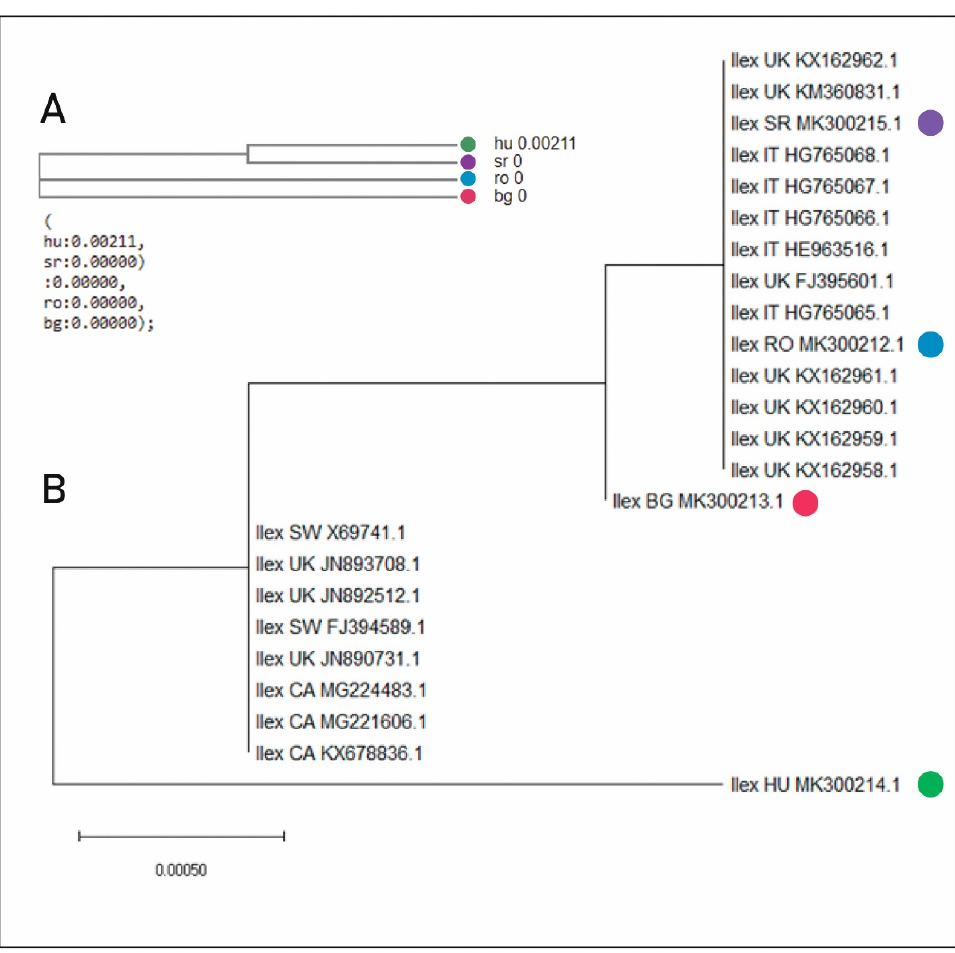
Figure 1. Neighbor-joining tree ( A ) and bootstrap consensus tree ( B ) for Ilex aquifolium . ( A ) Multiple alignment of all rbcL four sequences. ( B ) The codes indicate the NCBI accession numbers of the deposited Ilex aquifolium specific rbcL sequences, together with the country of origin: RO (blue), HU (green), SR (violet), BG (red), UK (United Kingdom), CA (Canada), SW (Switzerland) and IT (Italy).